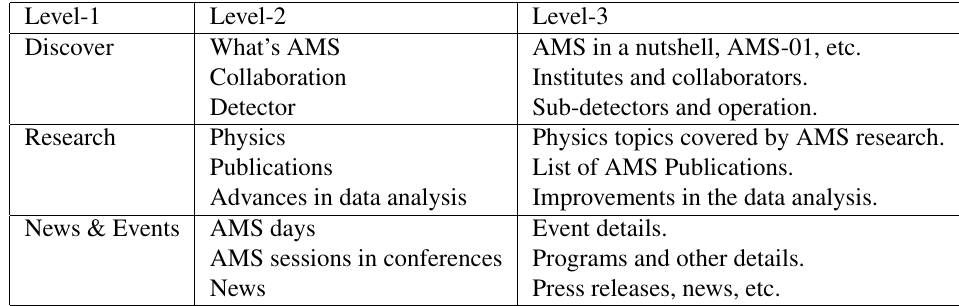
Figure 1. Website development workflow. Assignments are linked to three distinct roles. During the development, the production site is protected using a development site and several testbed sites. Sites can be synchronized once a major development update is accomplished. Table 1. Structure of the AMS